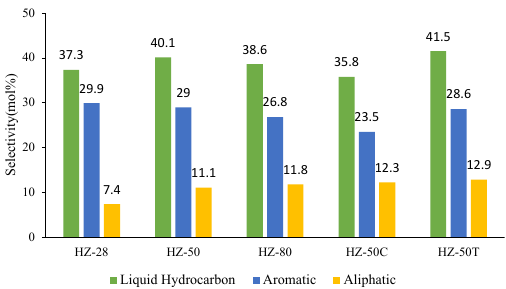
Fig. 6. Methanol conversion, liquid product, and gaseous Fig. 7. Liquid hydrocarbon as aromatic and aliphatic in HZ-28, Fig. 7 . Liquid hydrocarbon as aromatic and aliphatic in HZ-28, HZ-50, HZ-80, HZ-50C, HZ-50T samples for P = 1atm, T product in HZ-28, HZ-50, HZ-80, HZ-50C, HZ-50T samples HZ-50, HZ-80, HZ-50C, HZ-50T samples for P = 1atm, = 400 ºC, WHSV = 3 h -1 Fig. 6 . Methanol conversion, liquid product, and gaseous product in HZ-28, HZ-50, HZ-80, HZ-50C, HZ-50T samples for P = 1atm, T = 400 º C, WHSV = 3 h -1 . T = 400 º C, WHSV = 3 h -1 . for P = 1atm, T = 400 ºC, WHSV = 3 h -1